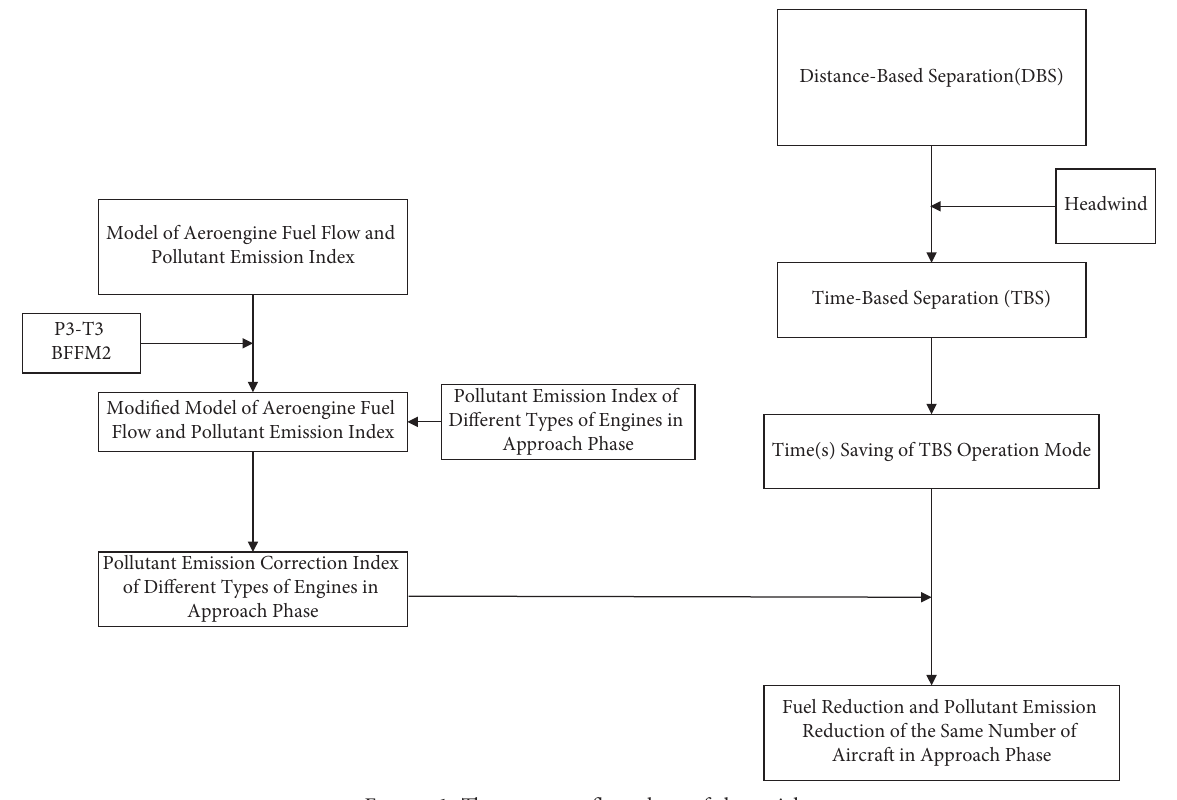
Figure 1: The structure flow chart of the article. Table 1: Average approach speeds of various types of aircraft.